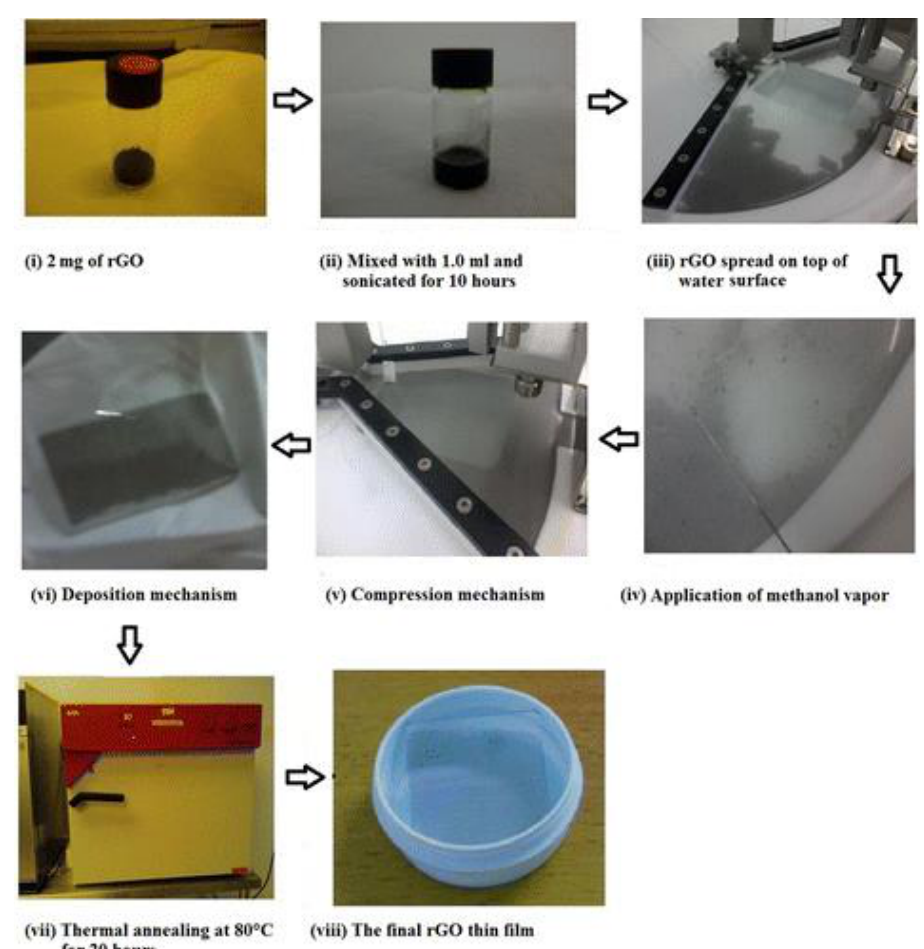
Figure 4. Flowchart showing the preparation of rGO LB film. To distribute the rGO flakes evenly, methanol vapor from a methanol-soaked tissue was applied to gently force the clouded regions apart to significantly improve the film uniformity. Reprinted with permission from ACS Publications, copyright 2015, American Chemical Society [34].